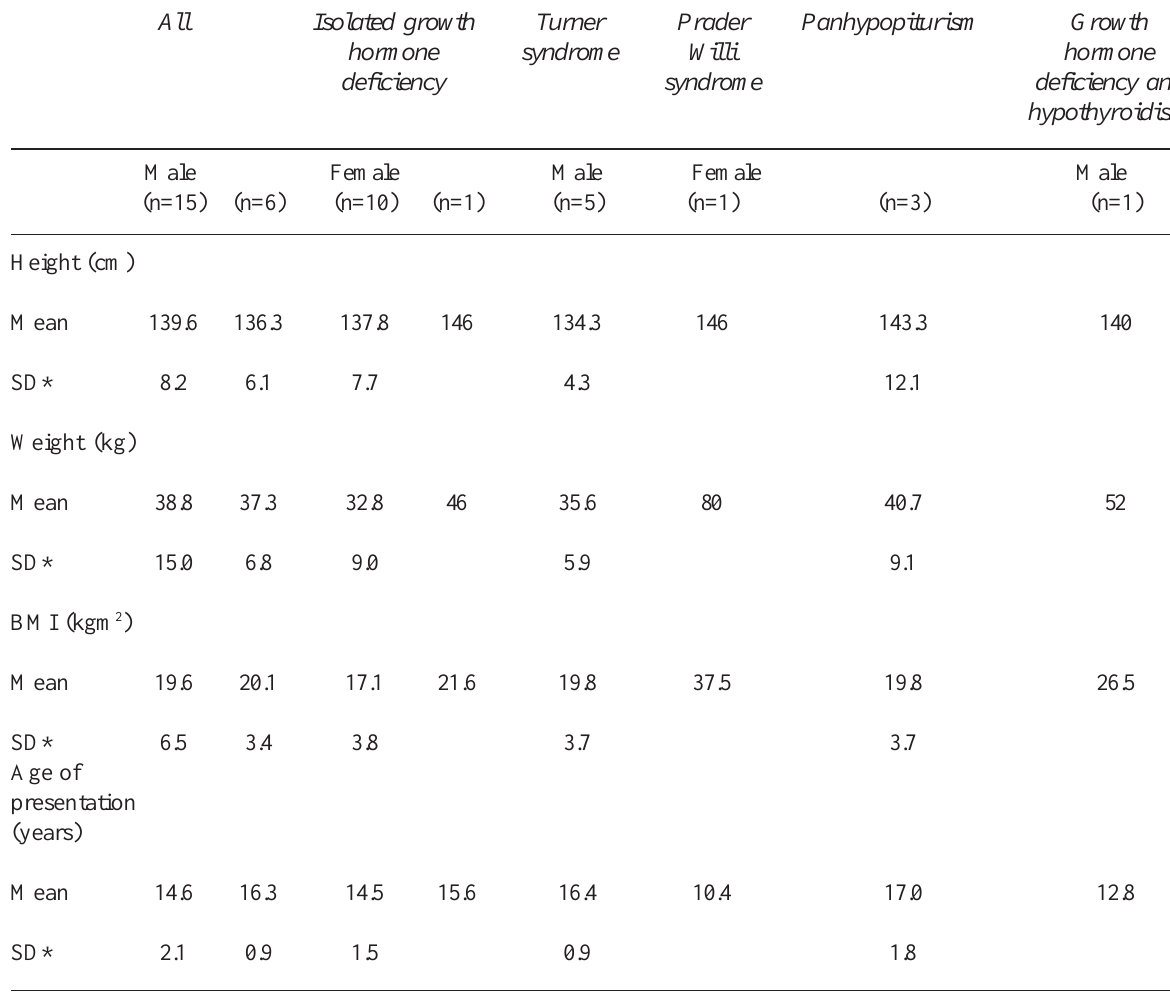
Table1. Sociodemographic variables of different groups of adolescents with short stature in the cohort All Isolated growth Turner Prader hormone Willi deficiency syndrome deficiency and